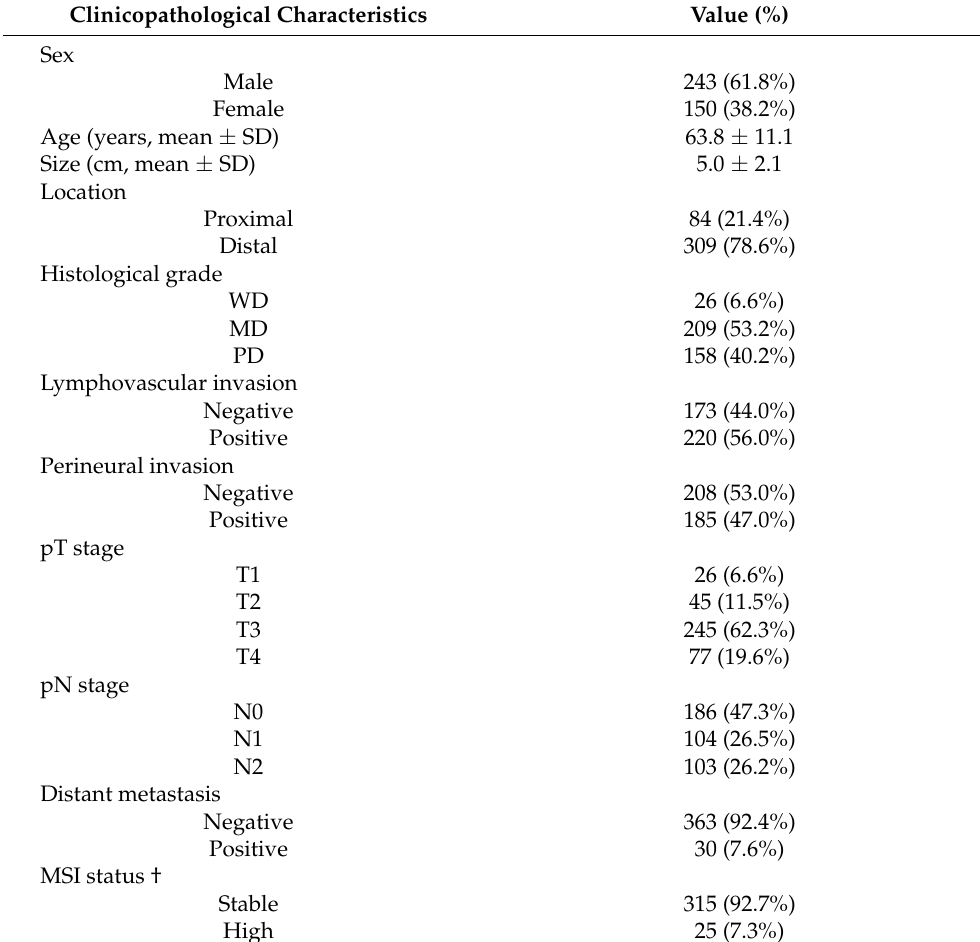
Table 1. Baseline characteristics of enrolled patients ( n =